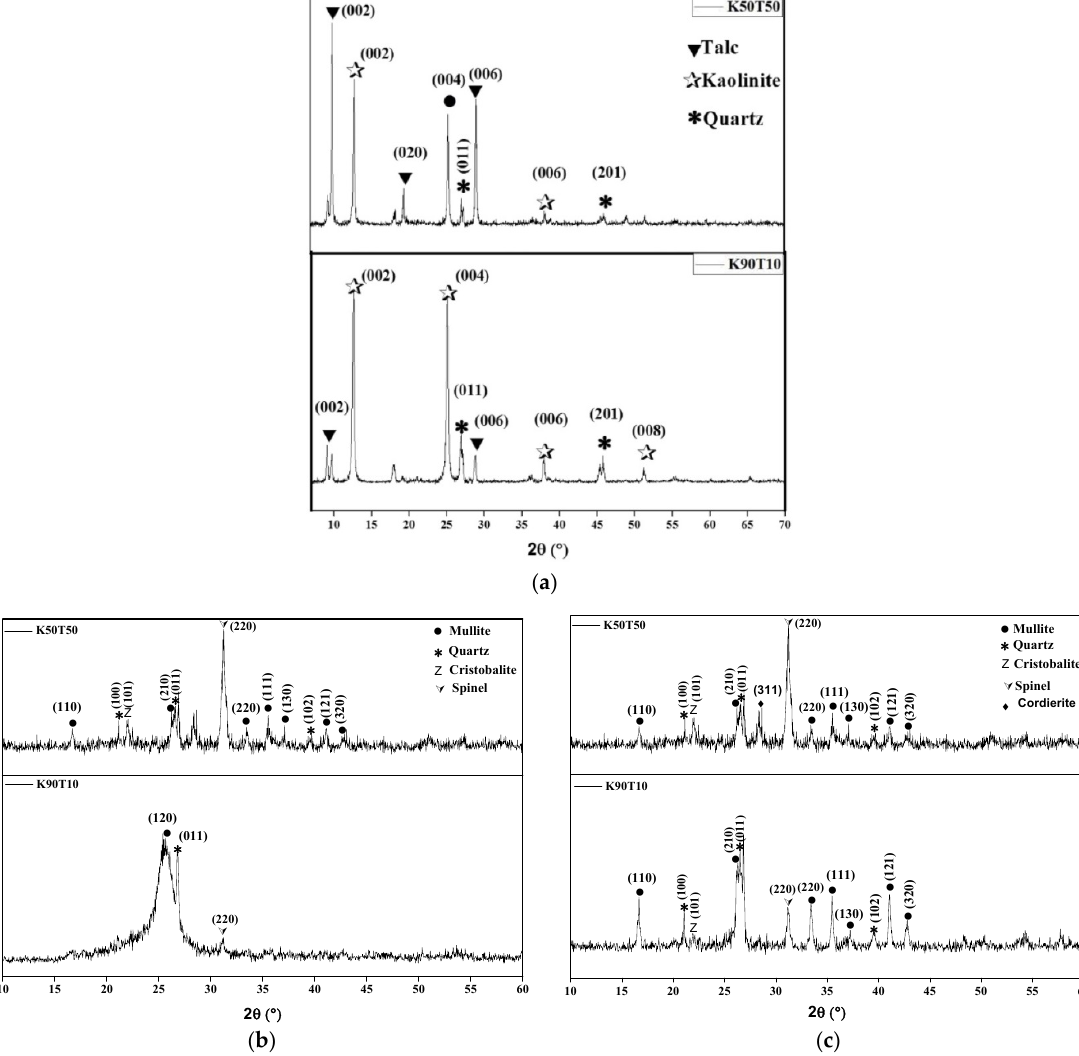
Figure 6. XRD patterns of K90T10 and K50T50 tapes: ( a ) green samples, ( b ) samples sintered at 1000 °C, and ( c ) samples sintered at 1100 °C.